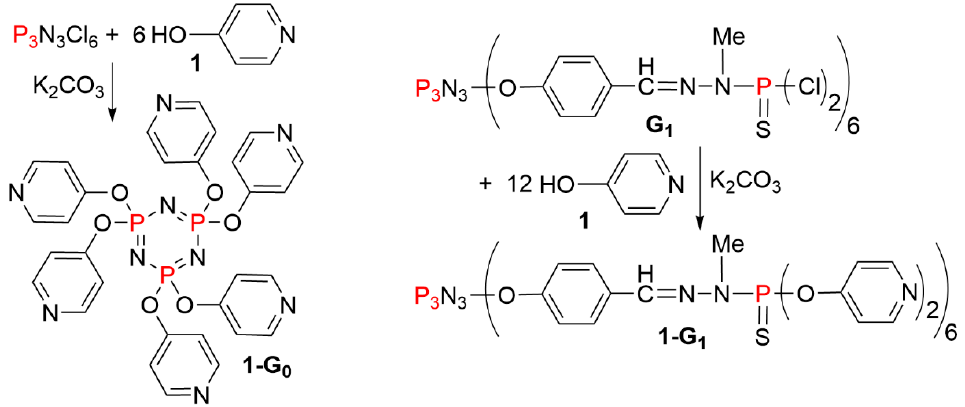
Scheme 3. Synthesis of phosphorus dendrimers 1-G 0 and 1-G 1 , functionalized by the N-ligand 1 .